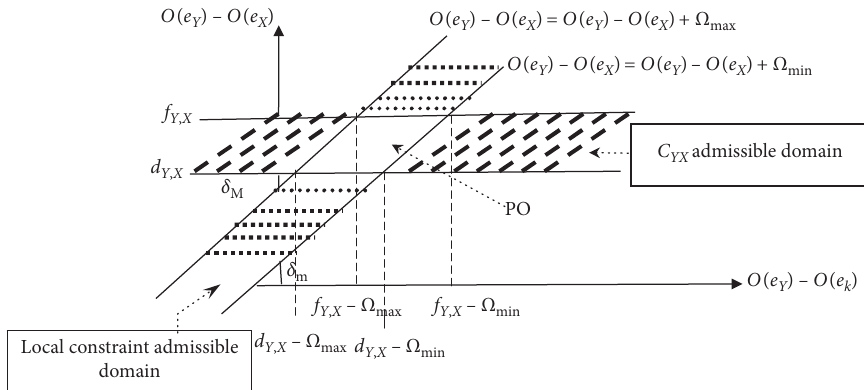
Figure 6: Representation of the admissible domain [19].